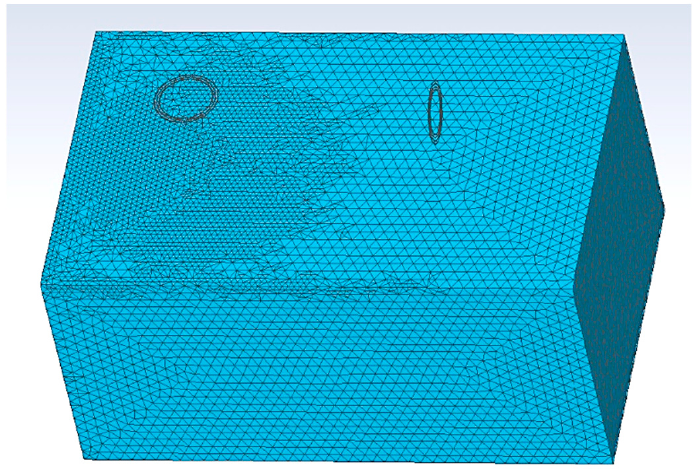
Figure 12. The photograph of the sensor above the container filled with saline water.